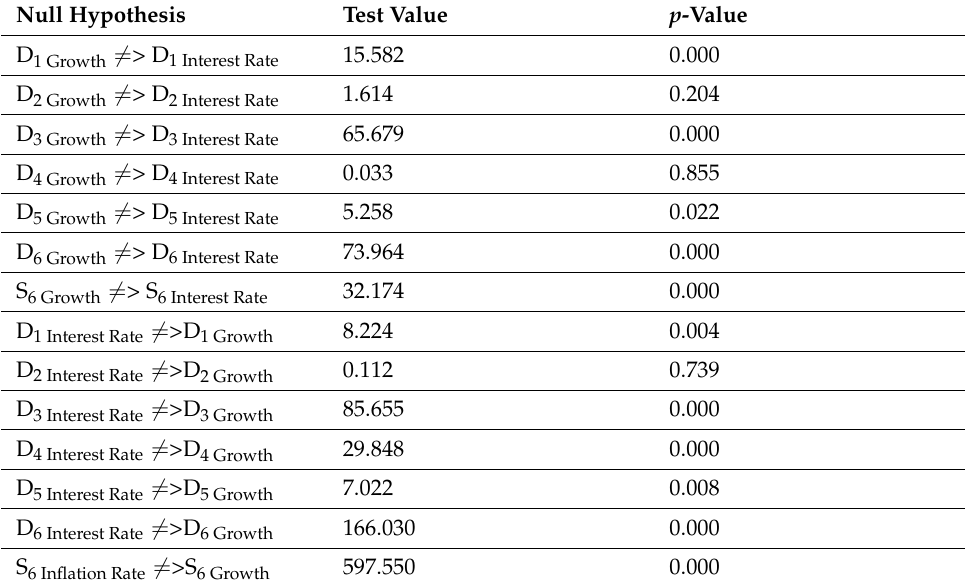
Table 7. Multi-scale Granger causality tests (growth and interest